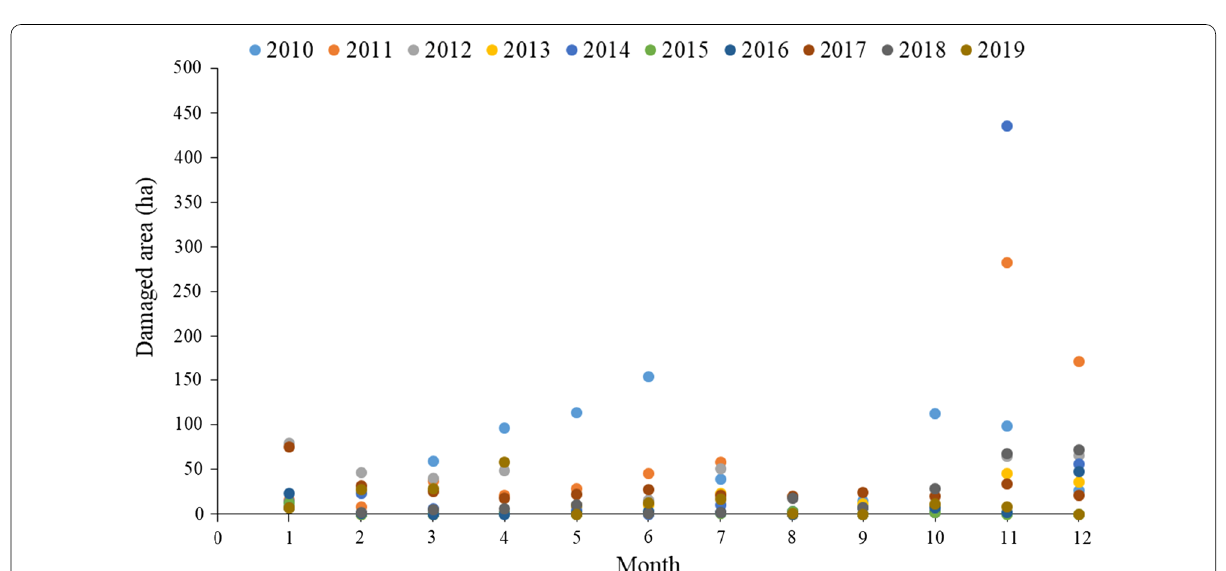
Fig. 7 Damaged area of corn field caused by Spodoptera litura in Lampung each month during